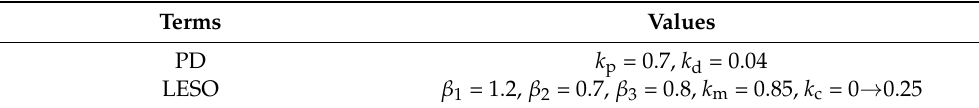
Table 2. Initial parameters in step